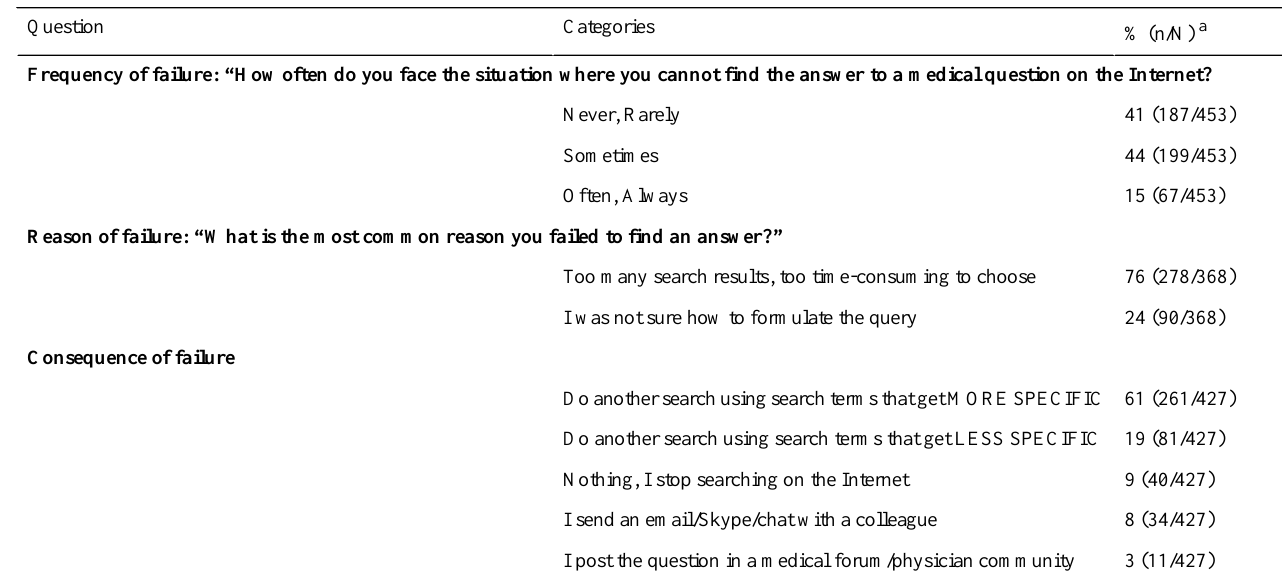
% (n/N) a CategoriesQuestion